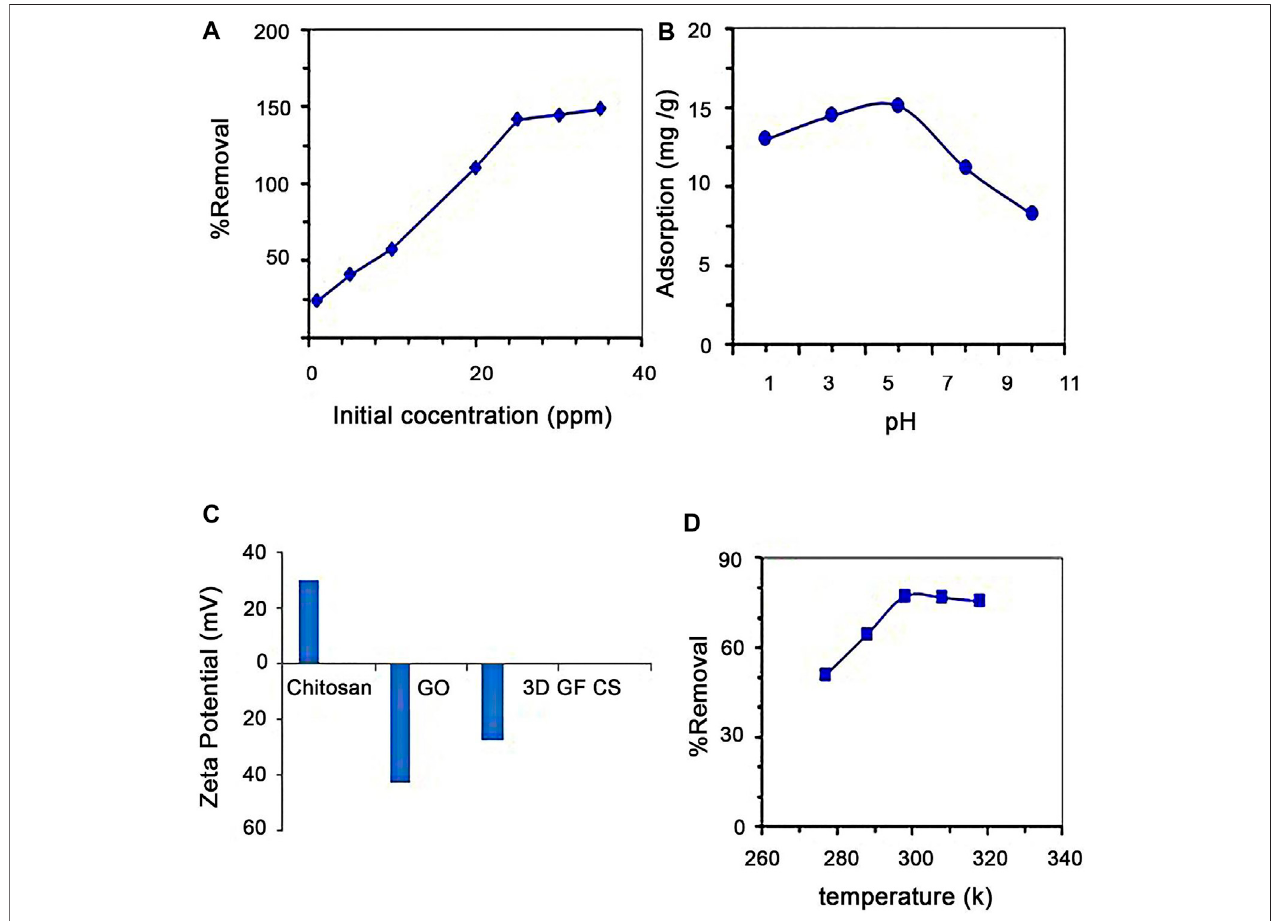
FIGURE 9 | Effect on the removal of SMZ (A) SMZ initial concentration, (B) pH, (C) zeta potential, and (D) temperature using 3D GF-CS.